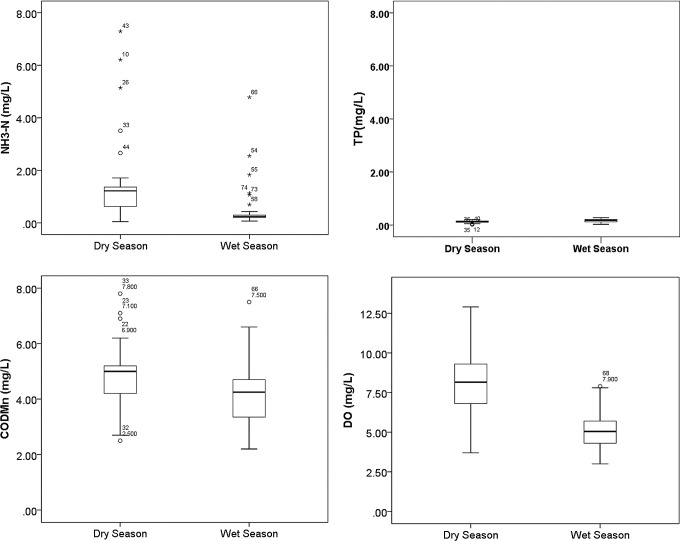
Boxplots of WQPs during the dry and wet seasons.